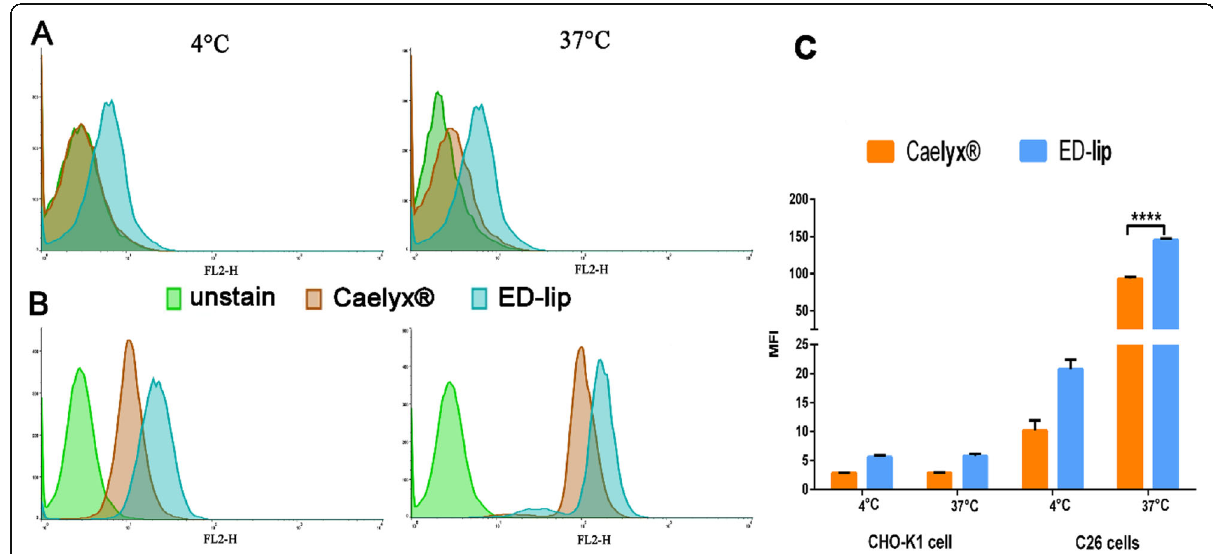
Fig. 4 Cell interaction and cell uptake of liposomal formulations evaluated in 4 °C and 37 °C. a The CHO-K1 cell interaction of the formulations at 4 °C and 37 °C. b The interaction of formulations with C26 cells at 4 °C and 37 °C. c The graph demonstrated mean MFI of formulations on CHO- K1 and C26 cells. Data represented as mean ± standard deviation (SEM) ( n = 3). **** p <